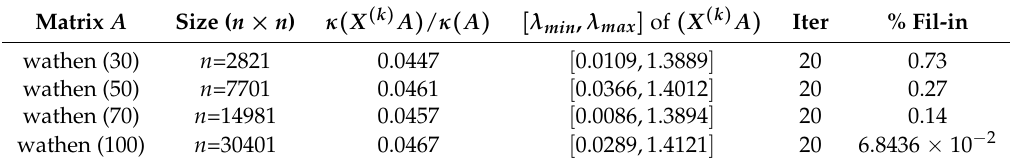
Table 4. Performance of MinCos applied to the Wathen matrix for different values of n and a